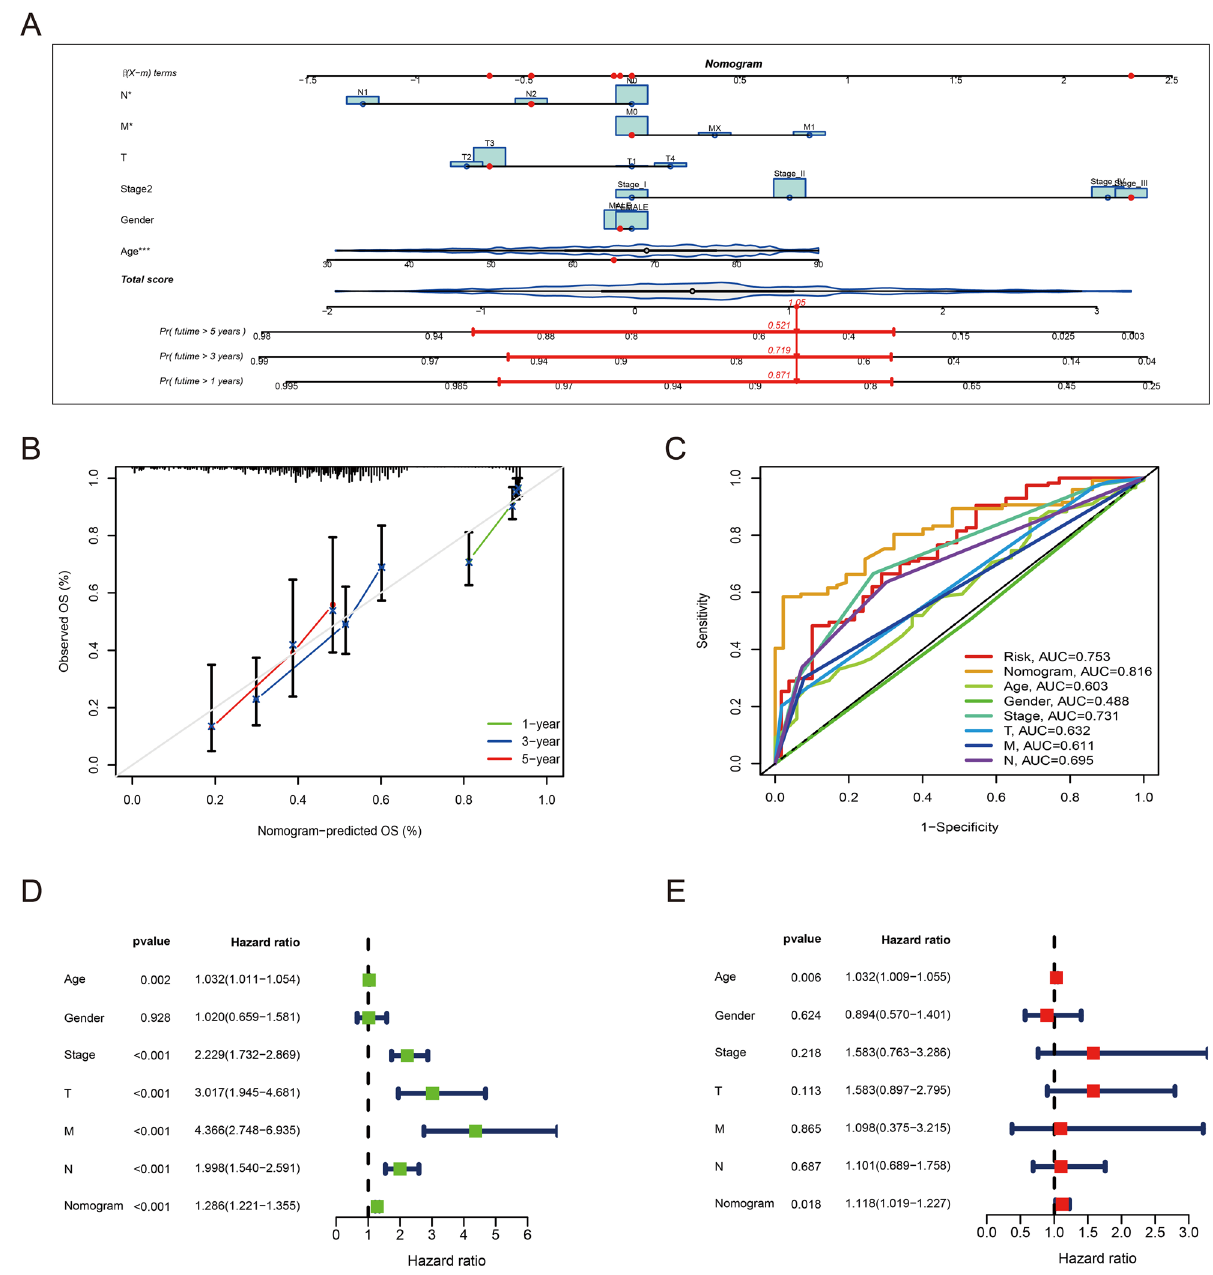
Figure 5. Construction of nomogram. ( A ) Nomogram to predict 1-, 3-, and 5-year overall survival in the TCGA-CRC cohort. ( B ) Calibration curves to assess the accuracy of a nomogram. ( C ) ROC curves of nomogram and clinical characteristics in the TCGA-CRC cohort. ( D ) Univariate independent prognostic analysis to determine whether the nomogram can be used as an independent prognostic factor. ( E ) Multivariate independent prognostic analysis to determine whether the nomogram can be used as an independent prognostic